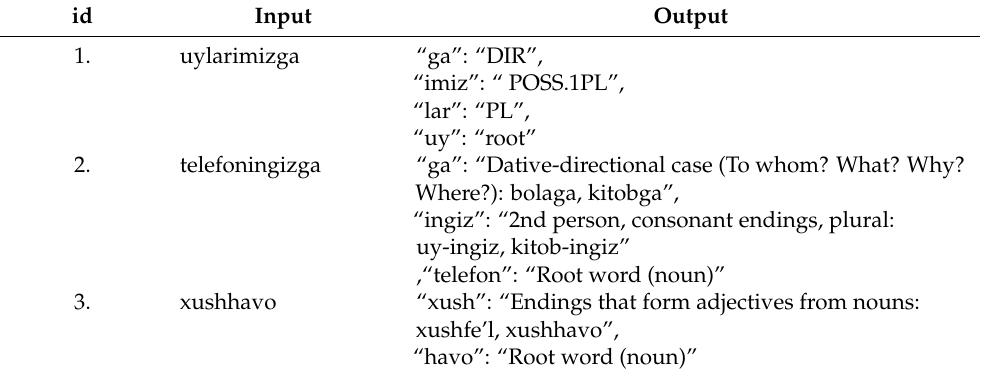
Table 13. Morphological analysis of words (words will be